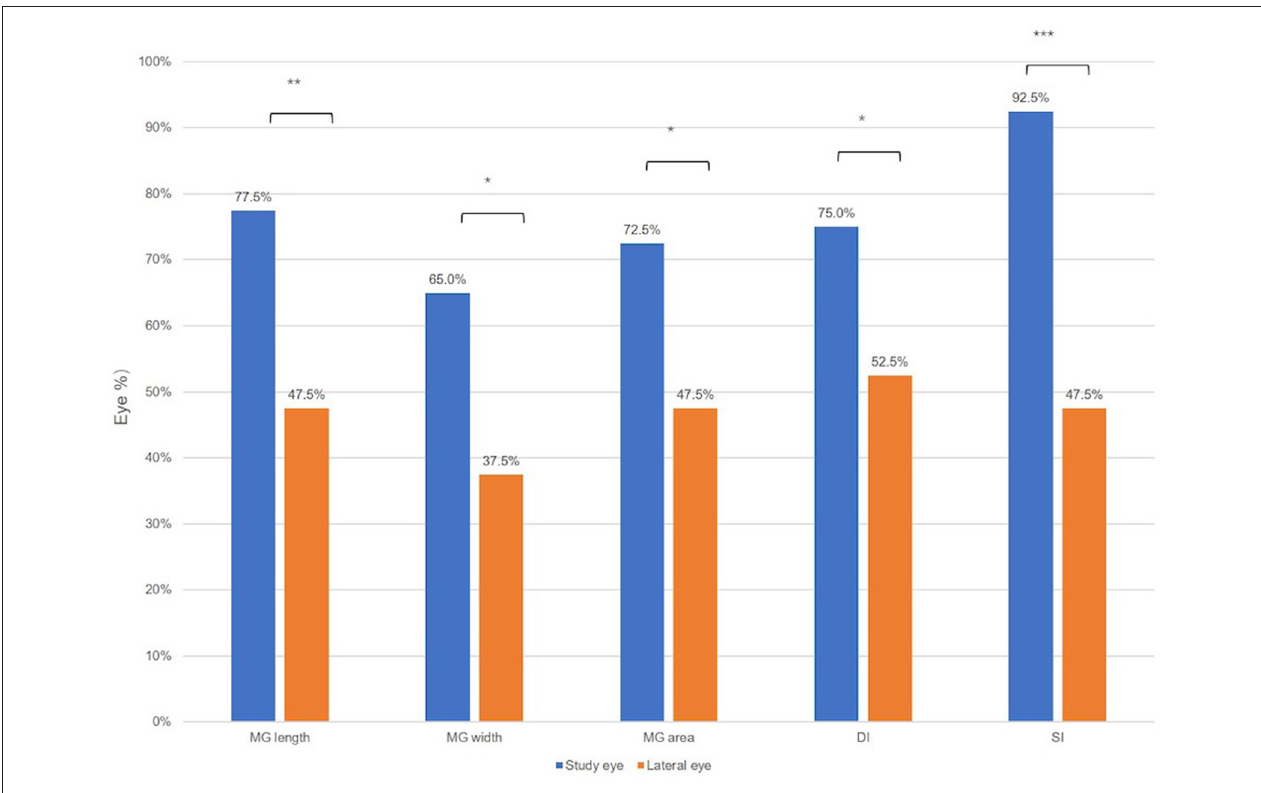
FIGURE 4 | The proportion of eyes whose ocular surface parameters value were decreased after the cataract surgery. Wilcoxon signed-rank test: * P < 0.05, ** P < 0.01, and *** P < 0.001.